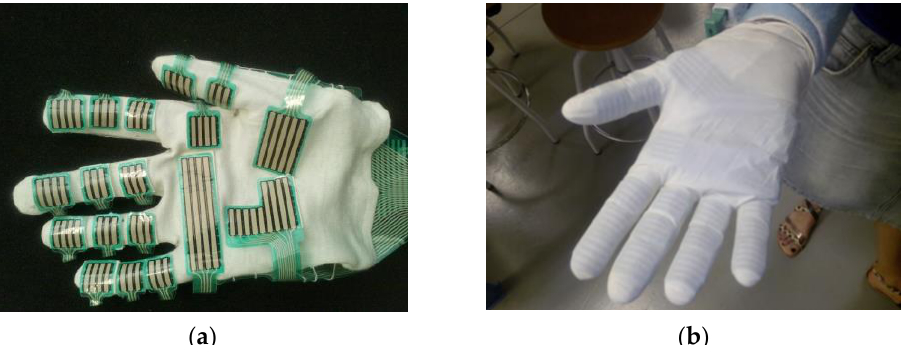
Figure 3. Pressure sensor sewn onto a cotton glove ( a ), final disposition in a subject’s hand covered with the additional polyethylene and latex gloves ( b ).